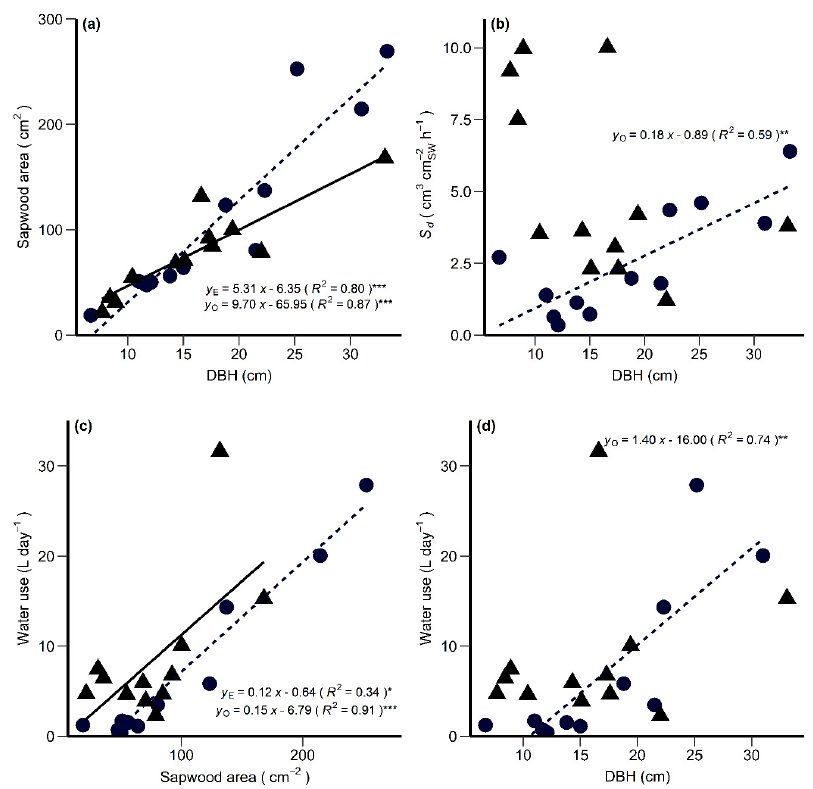
Figure 7. The relationships between sapwood area and DBH ( a ), sap flow density ( S d ) and DBH ( b ), water use and sapwood area ( c ), and water use and DBH ( d ) for post oak (circles) and redcedar (triangles). The linear regression equations (post oak dashed, redcedar solid) are shown when slopes are statistically significant. Asterisks denote level of significance with * at p < 0.05, ** at p < 0.001, and *** at p < 0.0001.